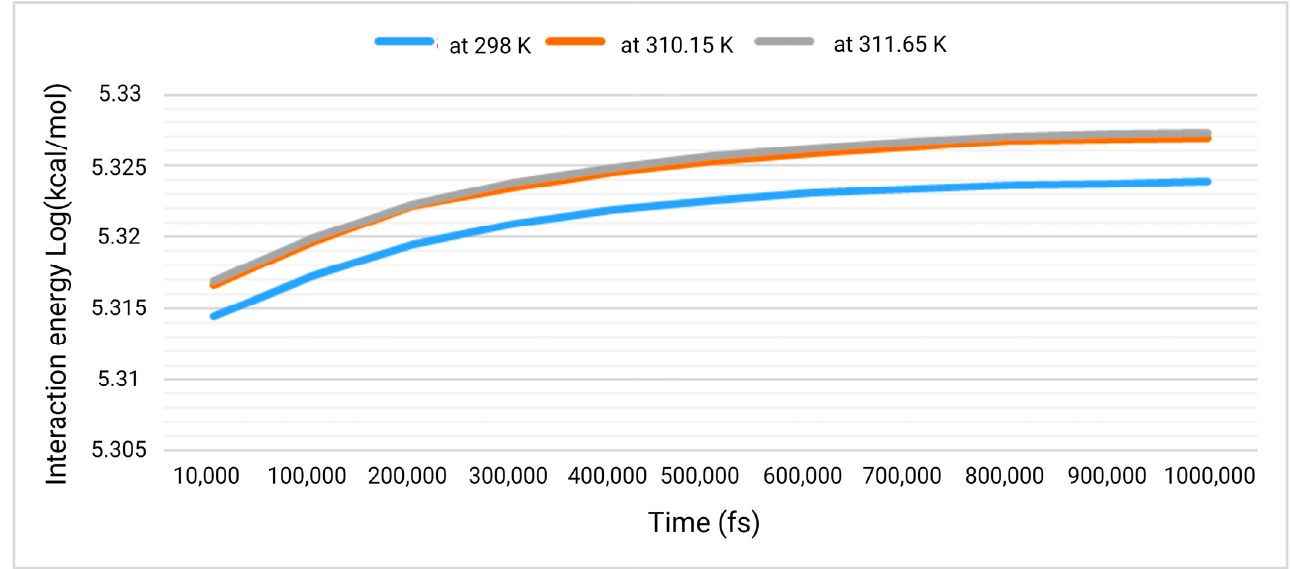
Figure 4. Total energy trend between FB and PAES membrane model. Table 2. Interaction energies between FB and the aryl sulfone